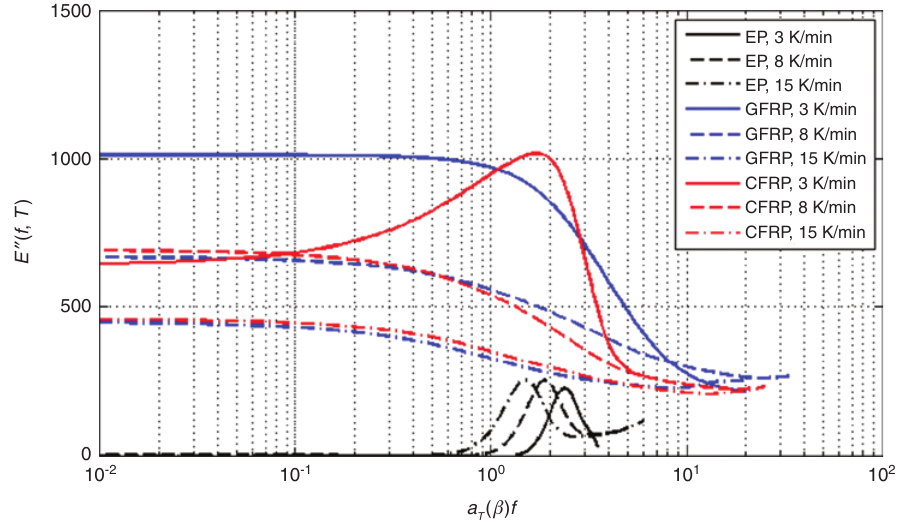
Figure 6: Master curves of the loss modulus for various materials and heating